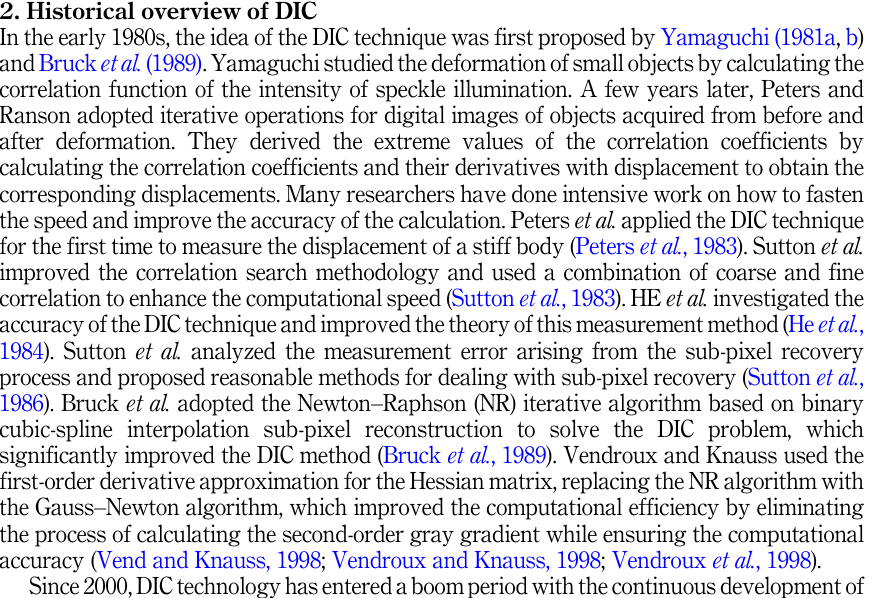
Figure 1. The typical workflow of DIC displacement